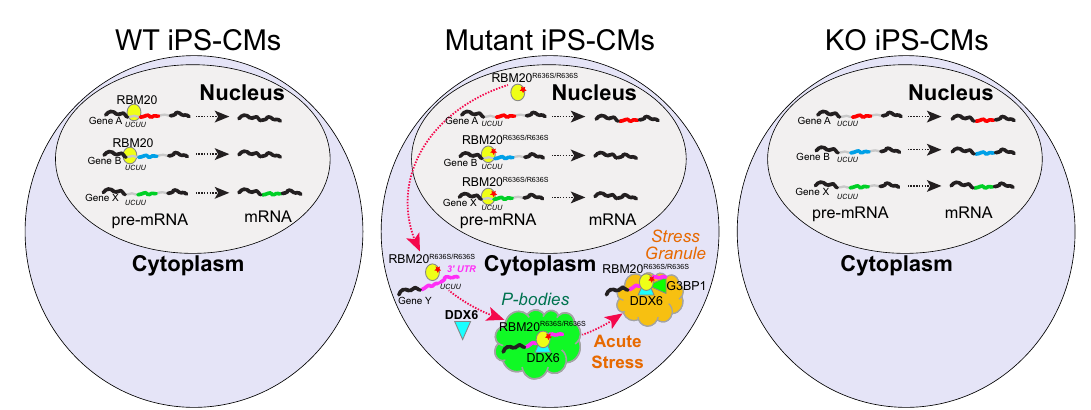
Fig. 6 Model of mutant RBM20 differential splicing and P-body impacts in dilated cardiomyopathy. Proposed model for the impact of wild-type and mutant RBM20 on nuclear regulation of splicing, based on RNA-Seq and eCLIP data, as compared to the cytoplasmic role of mutant RBM20 on P-body formation and 3 ′ UTR association with mRNAs implicated in granule